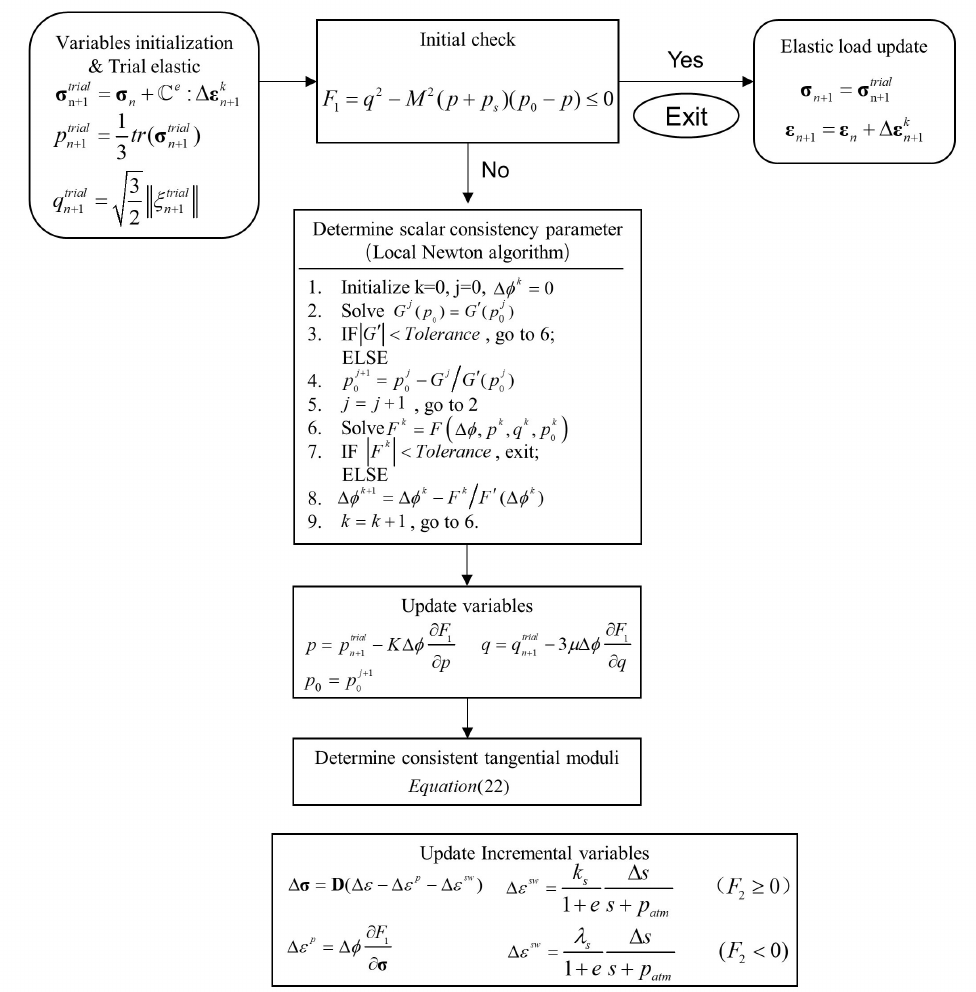
Figure 3. Numerical simulation implementation of the